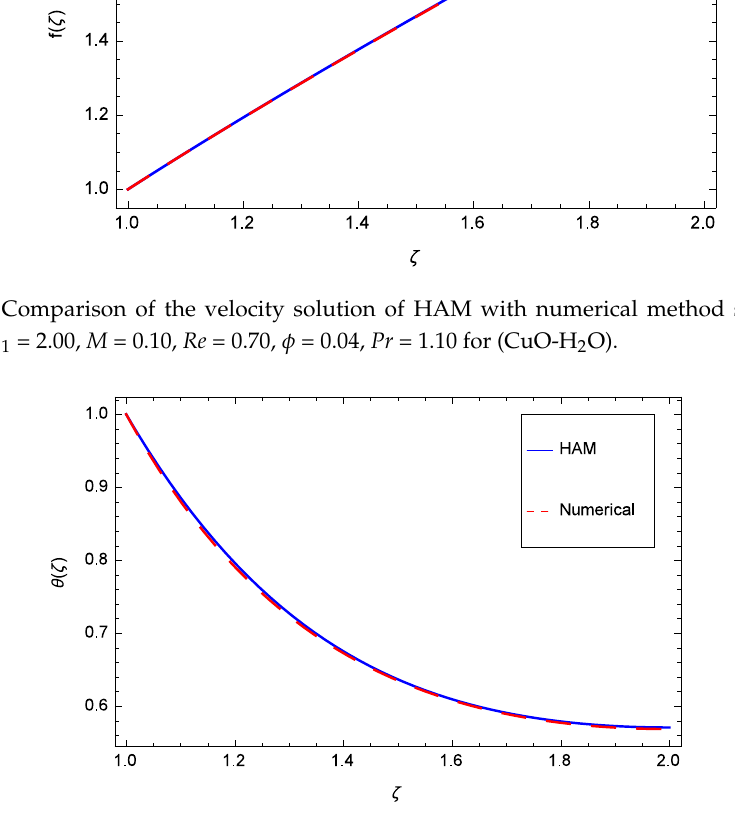
Figure 19. Comparison of the temperature solution of HAM with numerical method solution when h = − 0.55, β 1 = 2.00, M = 0.10, Re = 0.70, φ = 0.04, Pr = 1.10 for (CuO-H 2 O).